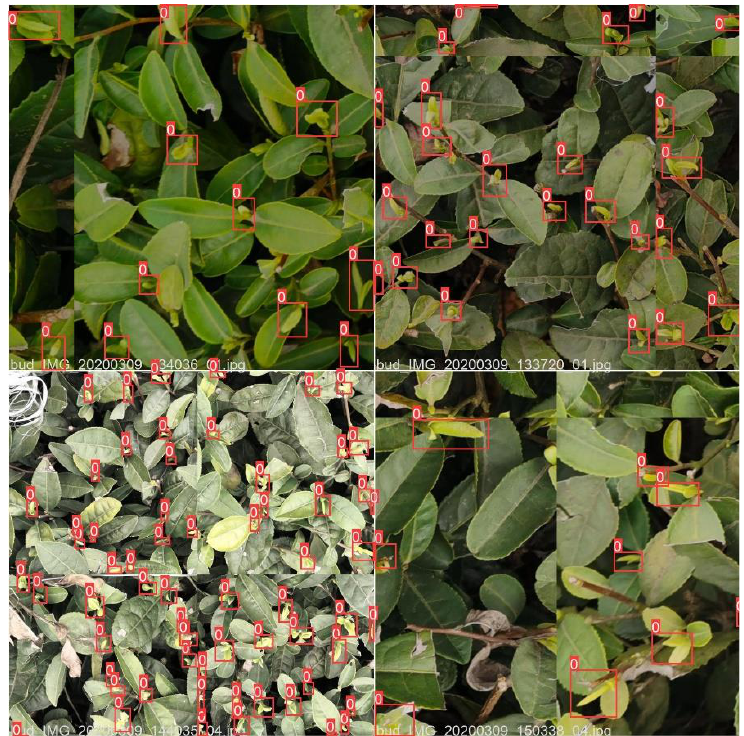
Figure 6. Image enhancement sample.